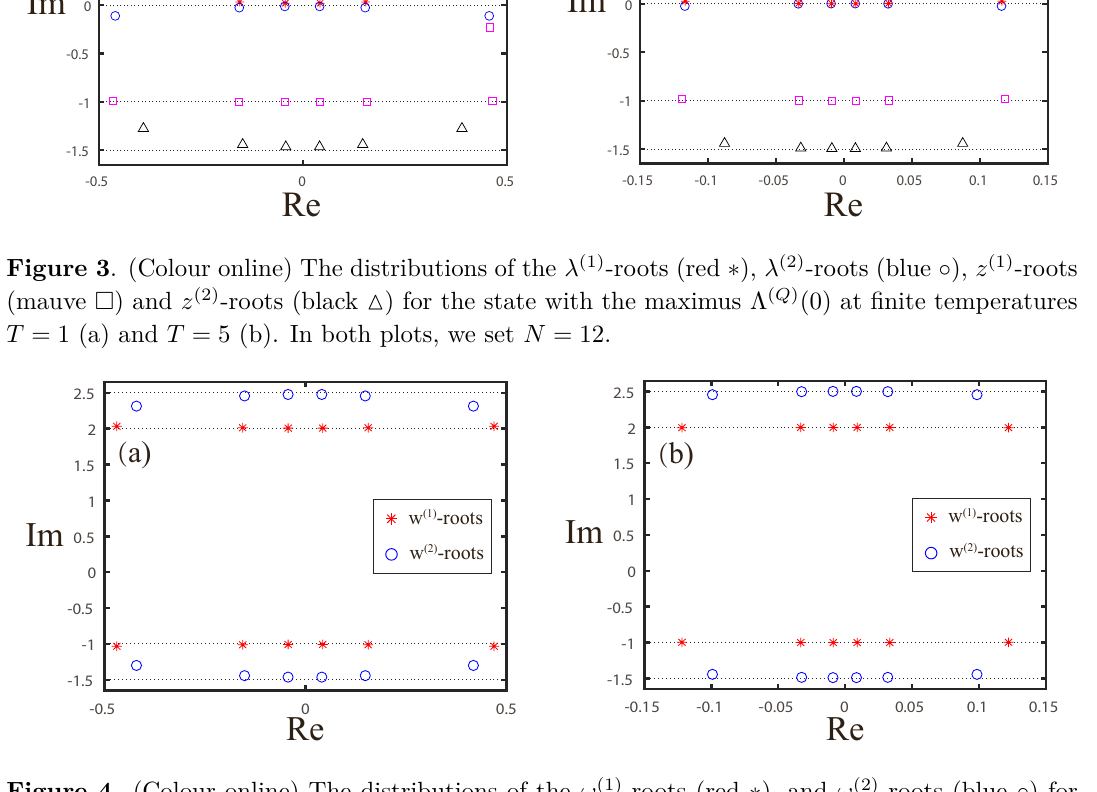
Figure 4 . (Colour online) The distributions of the ω (1) -roots (red ∗ ), and ω (2) -roots (blue ◦ ) for the state with the maximus Λ ( Q ) (0) at finite temperatures T = 1 (a) and T = 5 (b). In both plots, we set N = 12